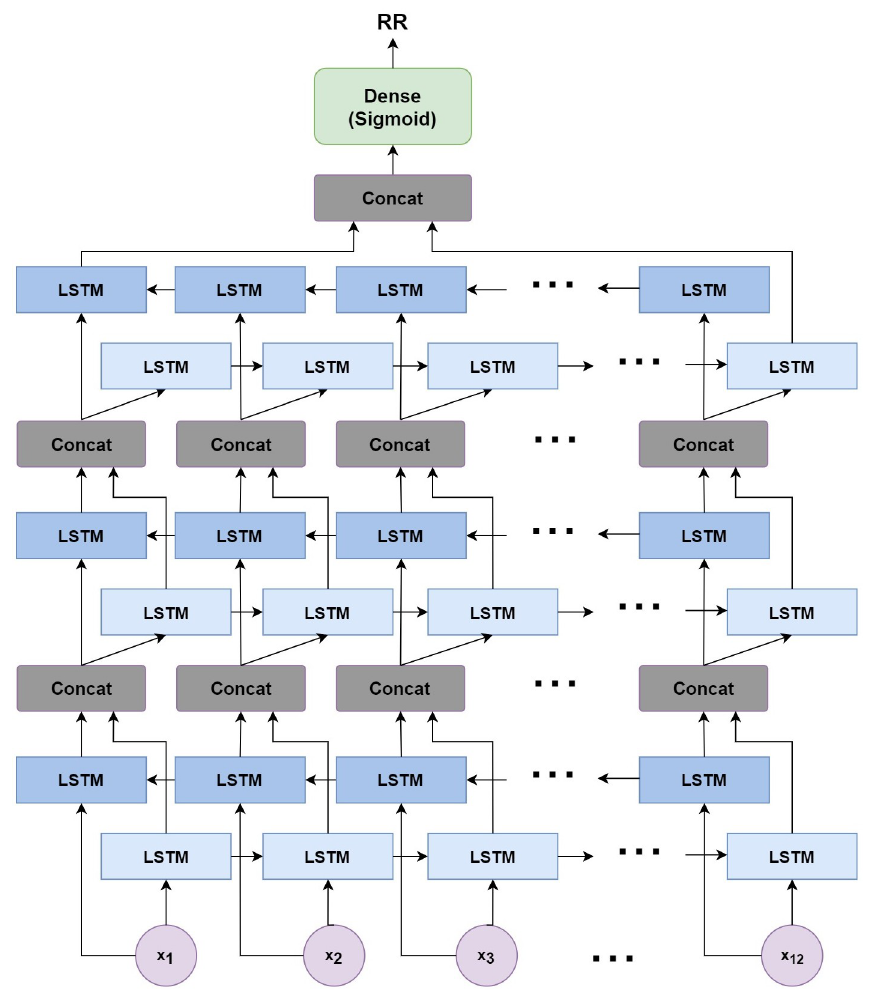
Fig 2. Structure of the BiLSTM